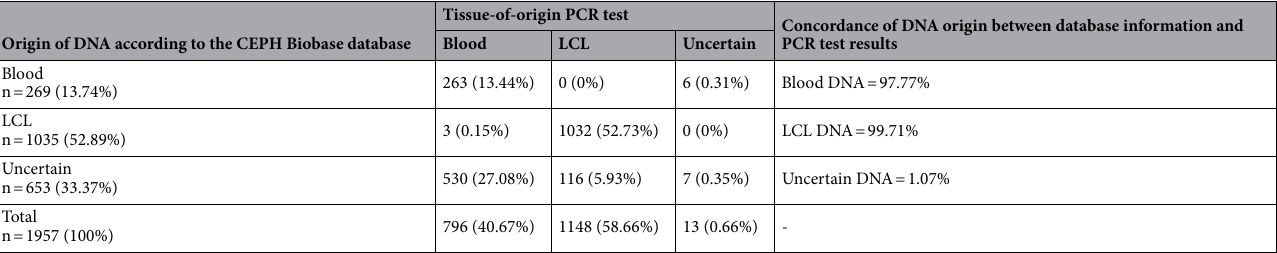
Table 3. Concordance between the information present in the CEPH Biobase database and results of real-time PCR tissue-of-origin assays.